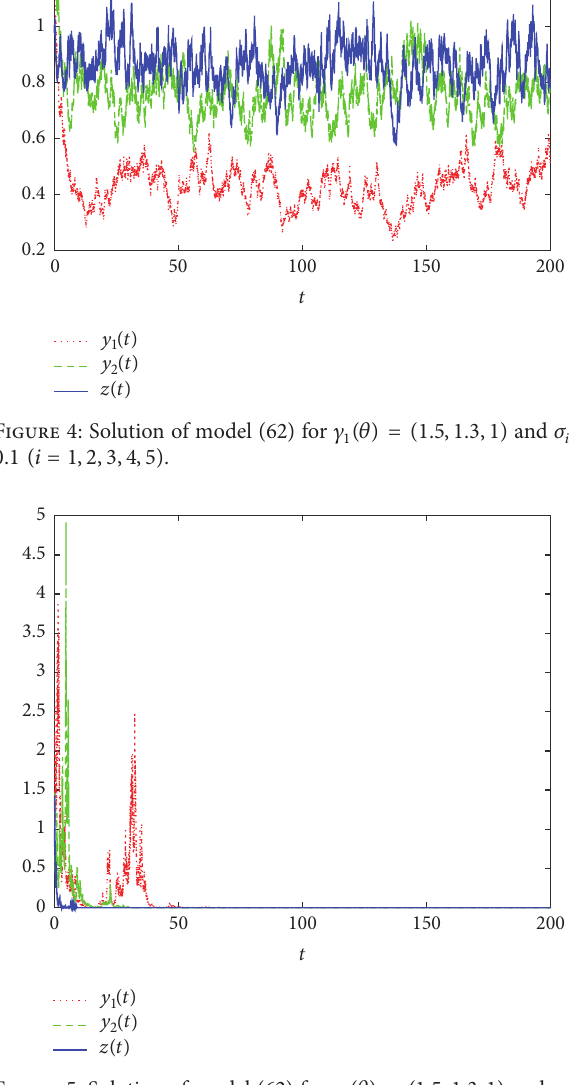
Figure 5: Solution of model (62) for 𝛾 1 (𝜃) = (1.5, 1.3, 1) and 𝜎 1 = = 0.1, 𝜎 = 1.05, 𝜎 = 1.5 , and 𝜎 = 0.95, 𝜎 2 3 4 5